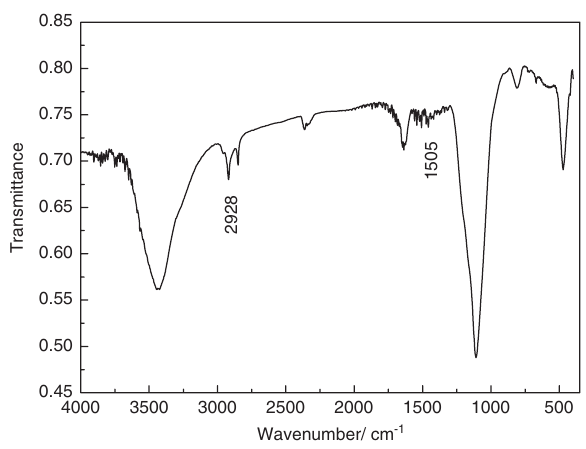
Figure 4 SEM morphology of particle distribution of unmodified nano-silica powder.